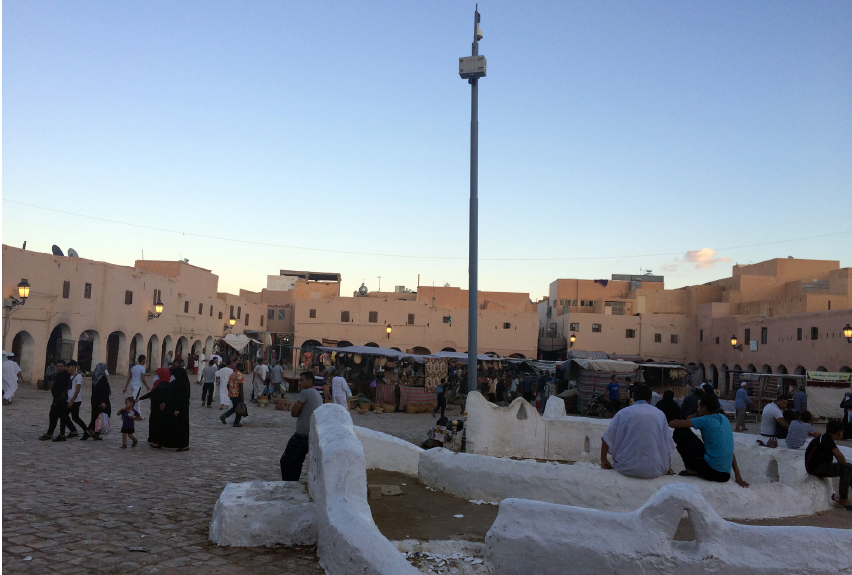
Fig. 9. The marketplace of Ghardaïa. Public benches for seats.